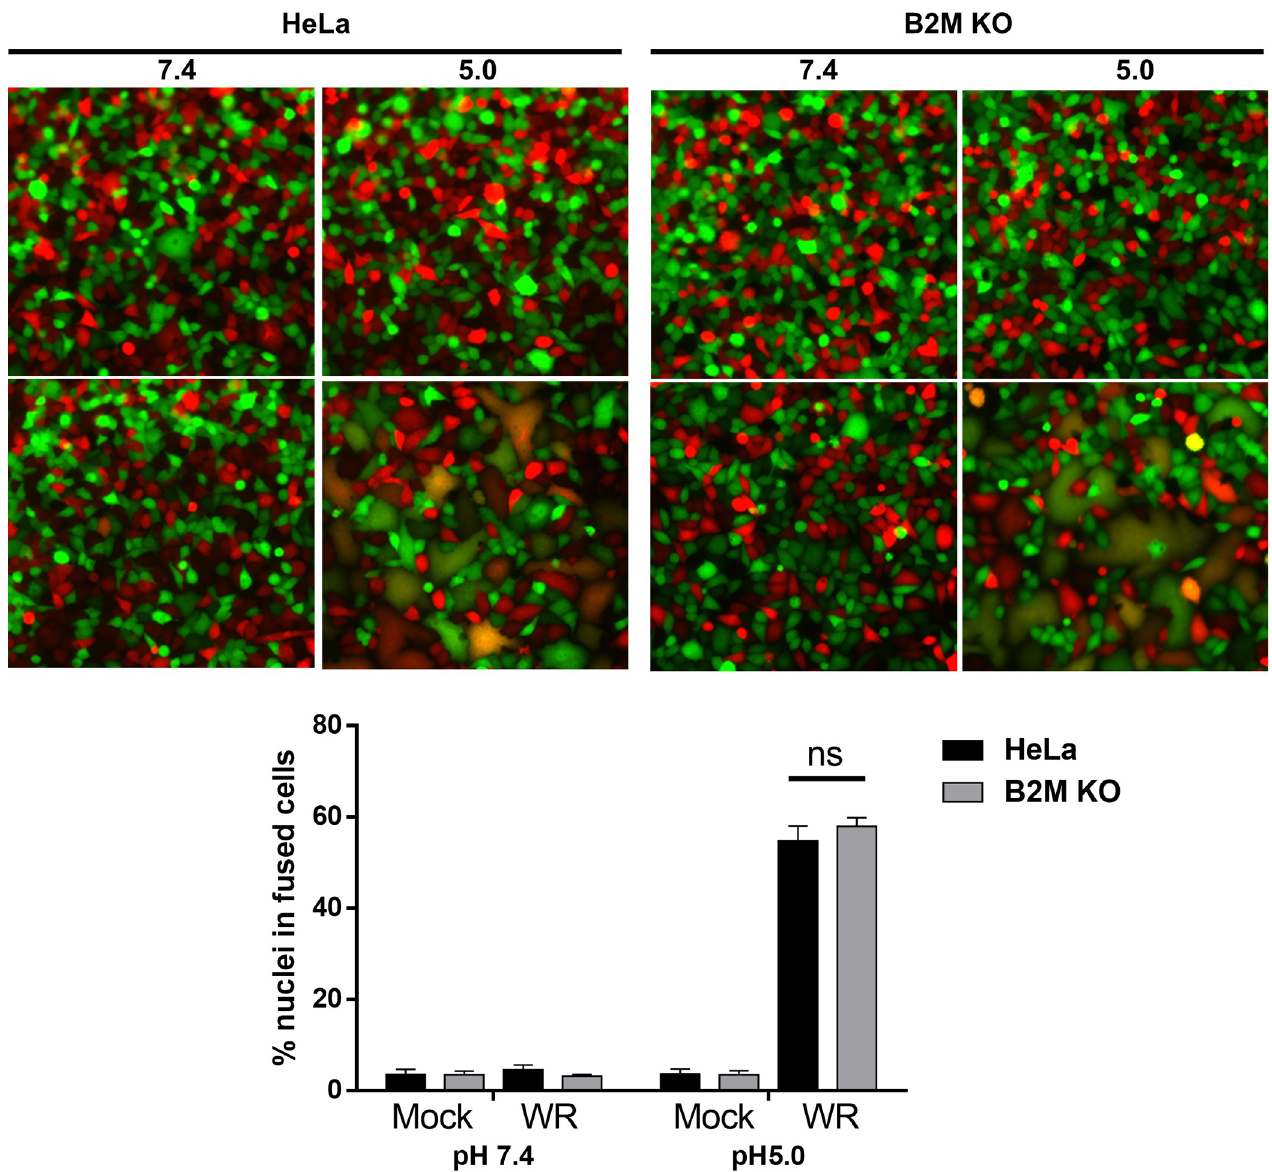
Fig 9. Cell-cell fusion induced by VV in HeLa B2M KO cells. Cells expressing either GFP or Scarlet fluorescent proteins were incubated with 100 PFU/cell of purified VV, and then treated for 3 min with buffer at pH 7.4 or 5.0. Two hours later, cells were fixed and photographed. The number of nuclei (n > 600) in syncytia and in individual cells were counted from multiple images. The percentage of nuclei in syncytia is represented in lower panel. ns, not significant.